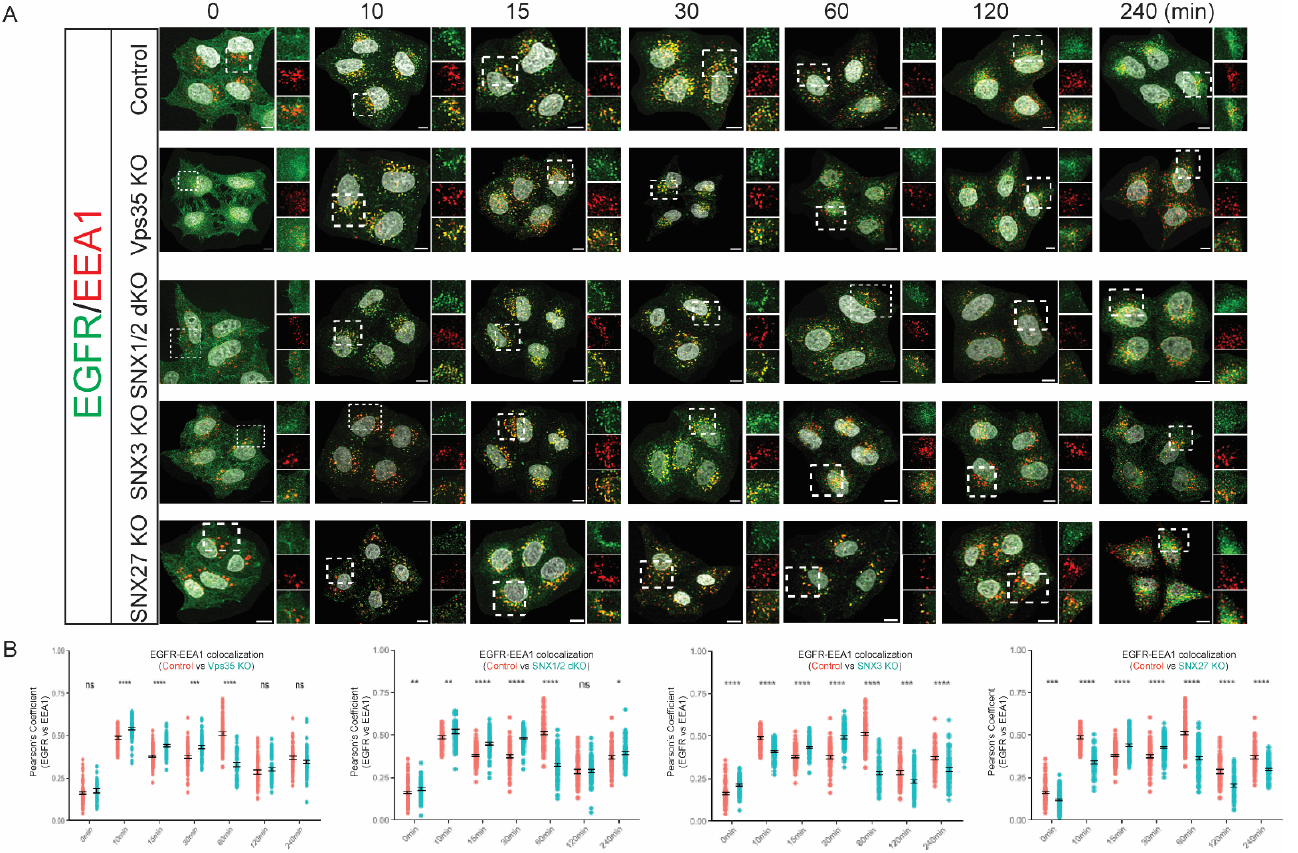
Figure 4. Retromer Vps35 and SNXs depletion altered the kinetics of EGF-stimulated EGFR sorting to early endosomes. ( A ) Serum-starved HeLa control, Vps35 KO, SNX1/2 dKO, SNX3 KO, and SNX27 KO cells were treated with 100 ug/mL of EGF for the time points as indicated before fixation and immunolabeling with EGFR and EEA1 antibodies. Images were captured on a Leica SP8 DMi8 confocal microscope using a 60× glycerol objective (Scale Bar, 10 µm). ( B ). Analysis of colocalization between EGFR and EEA1 is presented by Pearson’s correlation coefficient. The value shows the difference between HeLa control cells and KO cells (means ± SEM). Two-tailed student’s t -test indicated the difference between HeLa control and KO cells at the time points as indicated, ns, not significant, * p < 0.05; ** p < 0.01; *** p < 0.001; **** p < 0.0001.